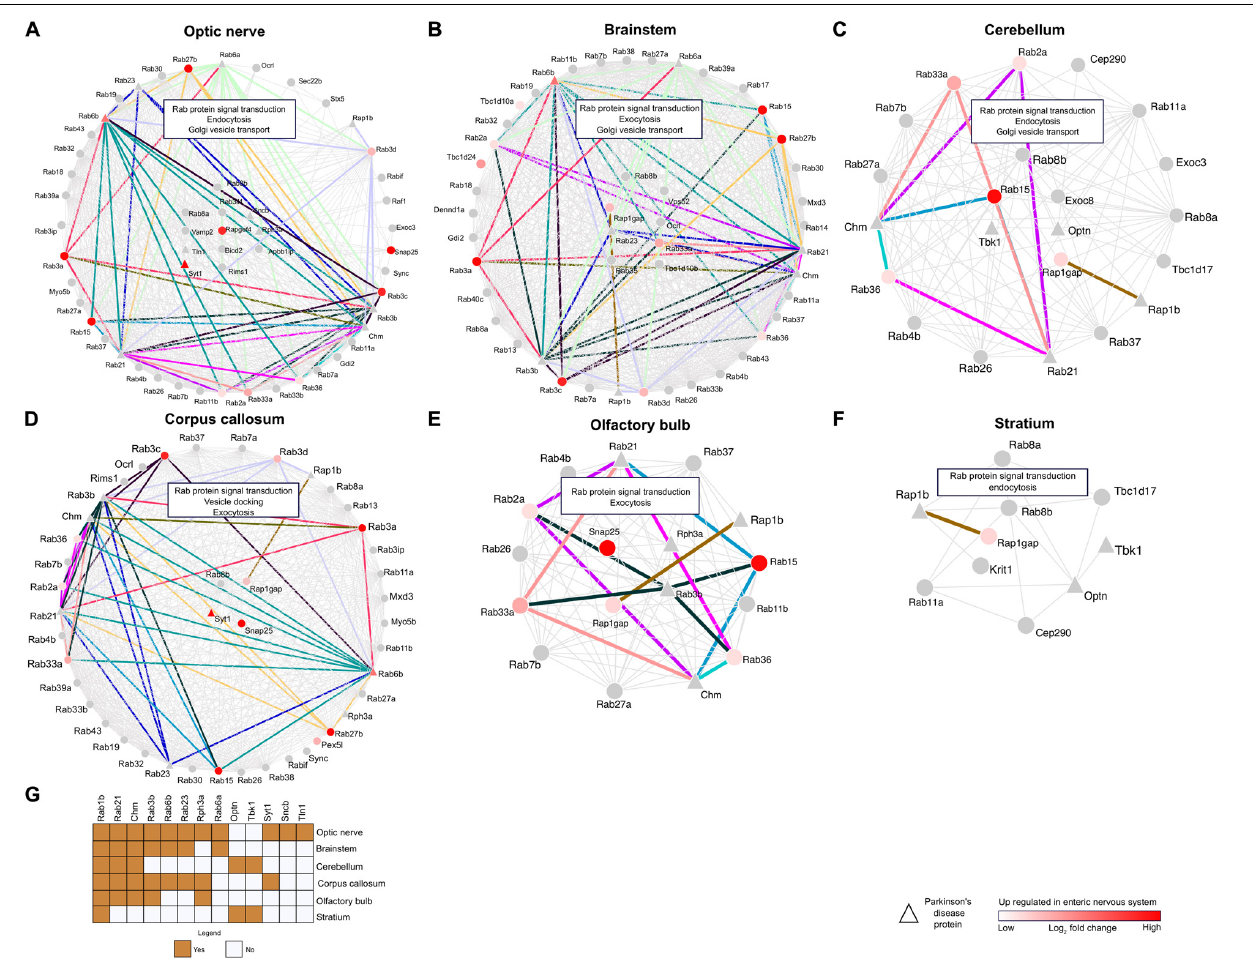
FIGURE 5 | Network analysis of brain region- and ENS-specific proteins. (A–F) Network plots showing the RRi and pathways regulated in the optic nerve, brain stem, cerebellum, corpus callosum, olfactory bulb, and striatum. Note: red color indicates upregulation of a protein in the ENS. Triangle shape nodes denote PD-related proteins. Colored lines indicate the interactions between the PD and ENS proteins. (G) The heatmap signifies the PD proteins between the brain regions.